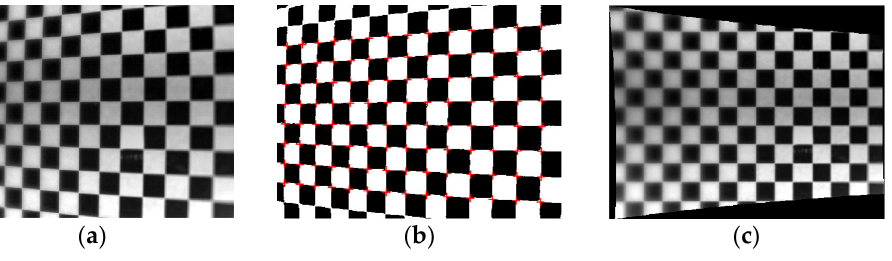
Figure 5. ( a ) Calibration image as it is recorded with the IR camera; ( b ) binary checkerboard grid with detected checkerboard corner points marked in red; ( c ) equidistant quadratic grid, obtained after the calculated transformation and used on the calibration image ( a ).